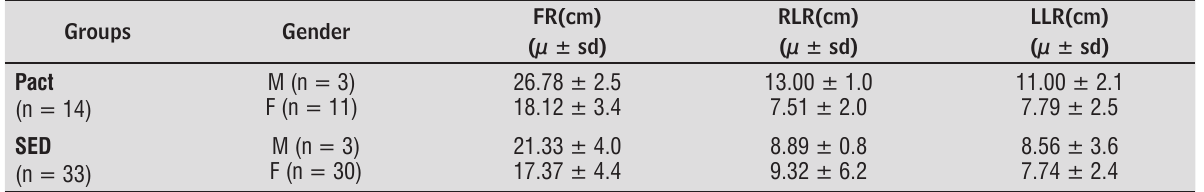
Table 3 - Means e standard deviations of Functional Reach and Lateral Reaches according to practice physical activity